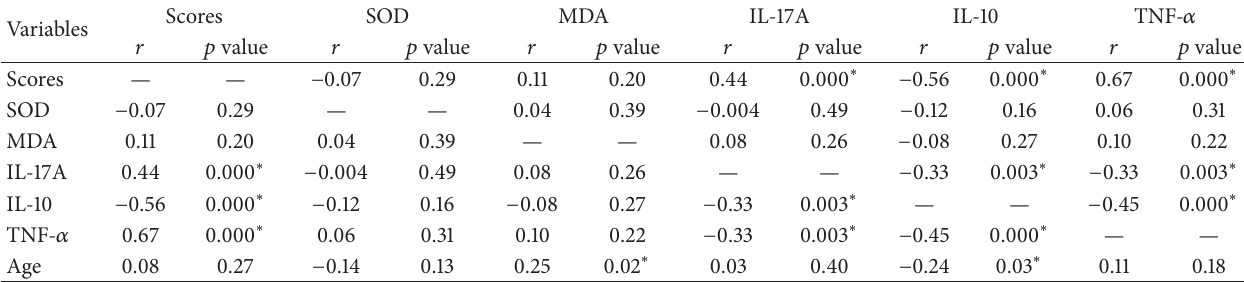
Table 2: Correlation analysis of scores, SOD, MDA, IL-17A, IL-10, and TNF- 𝛼 of HADAS subjects on the baseline.